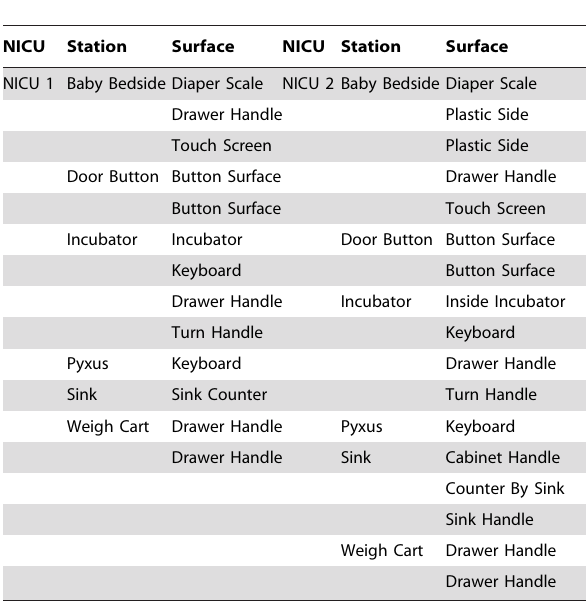
Table 1. Locations of surface sampling performed in two NICU